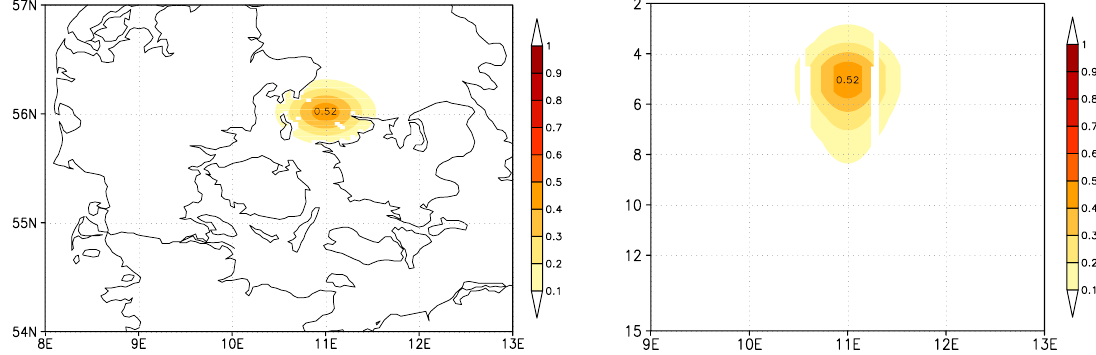
Fig. 4. The analysis increment corresponding to 1.0 unit innovation with an isolated T at Danish Water. Upper panel: horizontal distribution at 5m; bottom panel: cross section at 56 ◦ N.